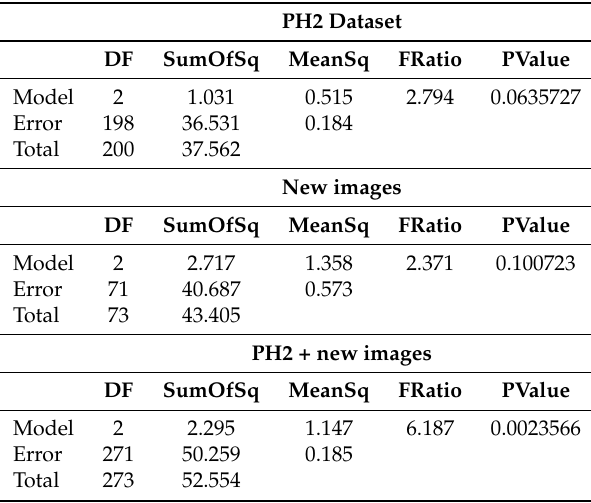
Table 2. Statistical results for the ANOVA test.